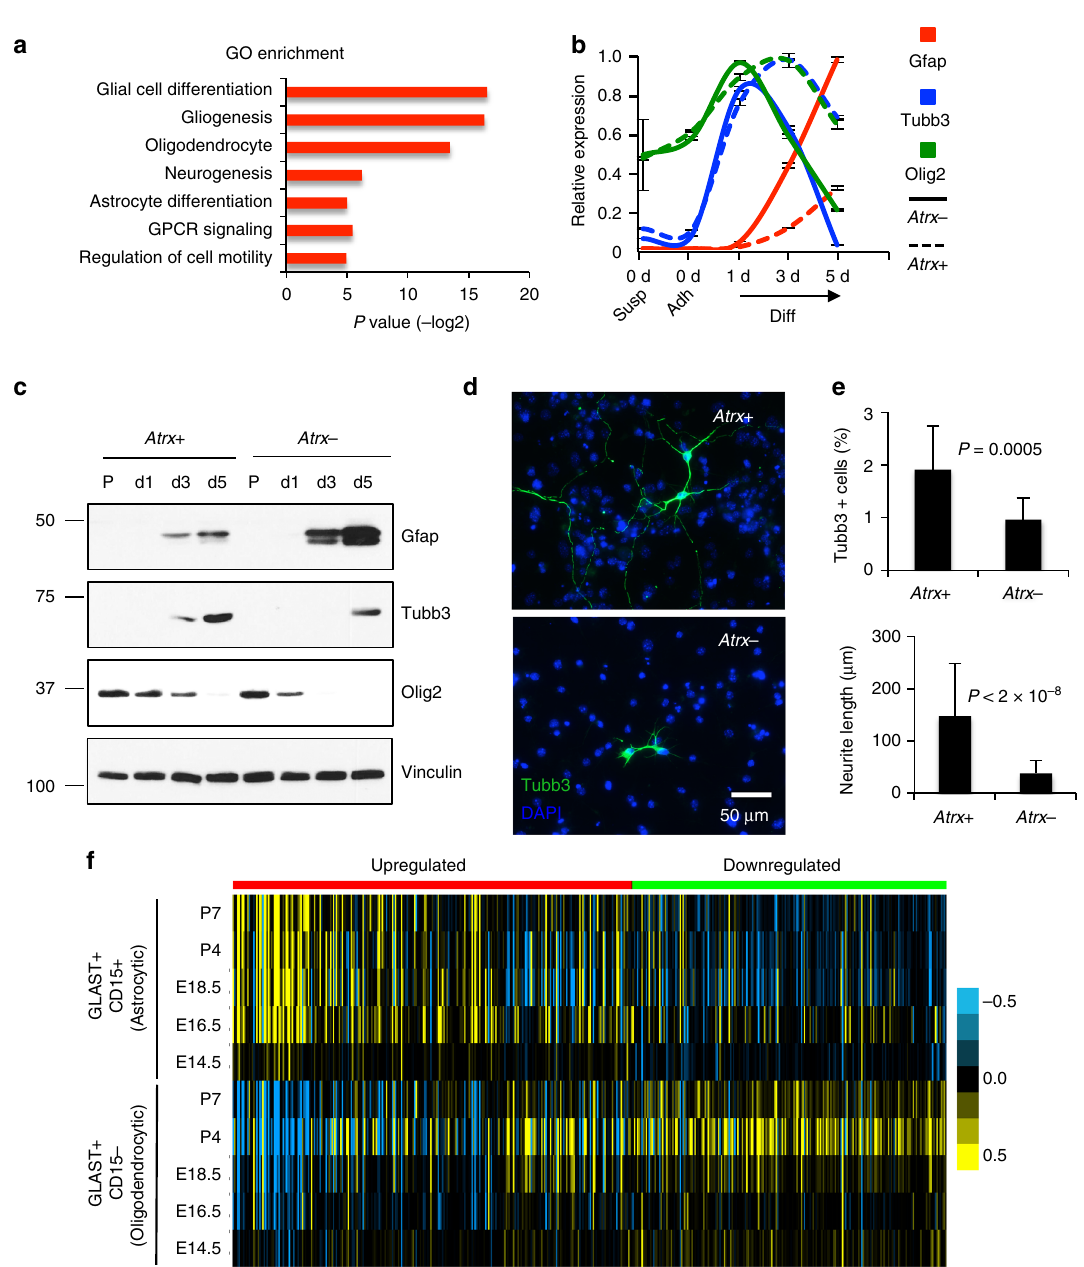
Fig. 2 Atrx de fi ciency modulates mNPC differentiation state. a Panther analysis of over expressed genes in Atrx- mNPCs reveals GO functional associations with development, signal transduction, and cellular motility (GPCR: G protein-coupled receptor). b relative transcript levels (RT-qPCR) of Gfap (red), Tubb3 (blue), and Olig2 (green) in Atrx + and Atrx - mNPCs (3 replicates per genotype) subjected to differentiation in vitro. Cells in proliferation conditions were sampled in suspension (Susp) and adherent to laminin (Adh), and then in differentiation conditions (Diff) after 1, 3, and 5 days (d). In all cases, data are scaled relative to the highest expression level for each marker across the sample set. Error bars re fl ect standard deviation. c western blot showing levels of histiogenic markers in Atrx + and Atrx − mNPCs in proliferation media (P) and in differentiation media for 1, 3, and 5 days (d1, d3, d5; Vinculin loading control). d , e Tubb3 (green) immuno fl uorescence images ( d ) and quanti fi cation ( e ) showing reduced neuronal processes and a lower number of Tubb3 + cells in Atrx- mNPCs after 5 days in differentiating conditions. In upper plot, data represent the average percentage of Tubb3 + cells counted in 15 fi elds at ×20 magni fi cation for each genotype; in lower plot, data represent the average length of Tubb3 + protrusions, 30 cells/genotype analyzed (DAPI counterstain; error bars re fl ect standard deviation; P values determined by unpaired two-tailed t -test). f heat map showing how differentially transcribed genes in Atrx - mNPCs (upregulated and downregulated) are expressed in distinct astrocytic and oligodendrocytic precursor compartments. Embryonic days 14.5, E16.5, and E18.5 (E14.5, E16.5, and E18.5) and postnatal days 4 and 7 (P4 and P7) are